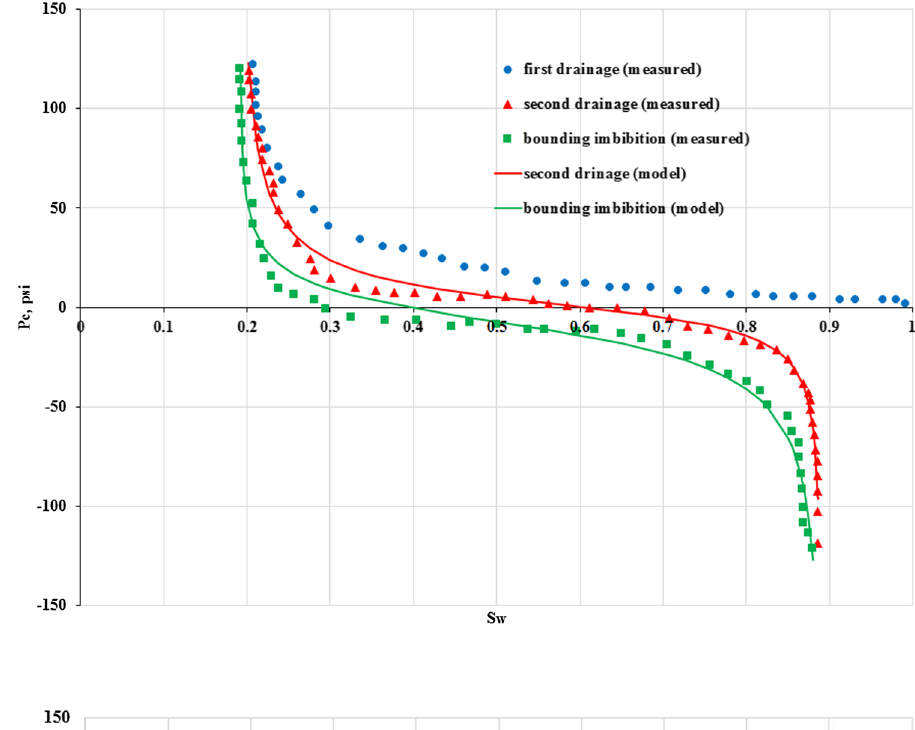
Fig. 4 Curve fitting of bounding imbibition and secondary drainage P c for